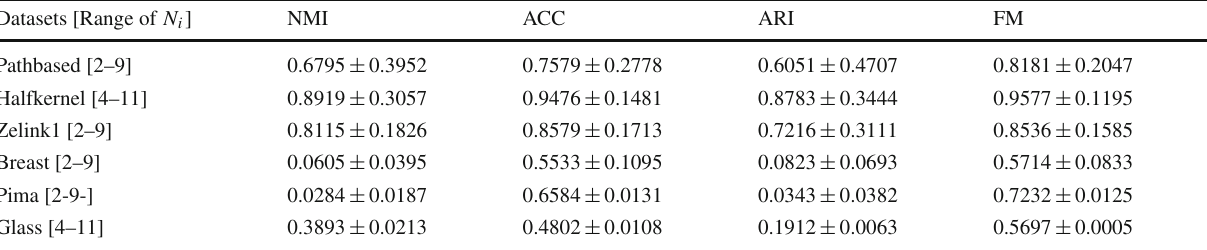
Table 12 Sensitivity analysis of AmDPC algorithm to parameter C 1 Datasets [Range of C 1 ] NMI ACC Pathbased [2.5–2.6]